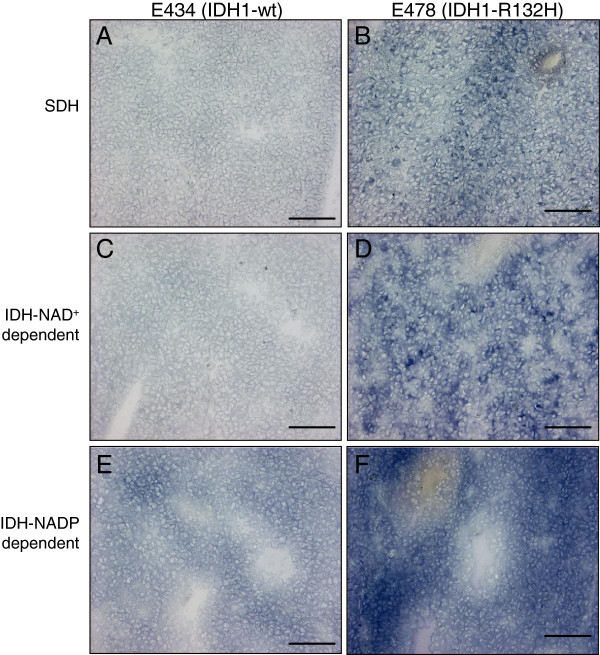
Metabolic mapping. Localization of activity of SDH (A,B), NAD+-dependent IDH (C,D) and NADP+-dependent IDH (E,F). The blue color represents the activity of the respective dehydrogenases after 15 minutes of incubation at 37°C. Note the high activities of mitochondrial dehydrogenases in E478 xenograft as compared with the E434 xenograft. Bar = 100 μm.